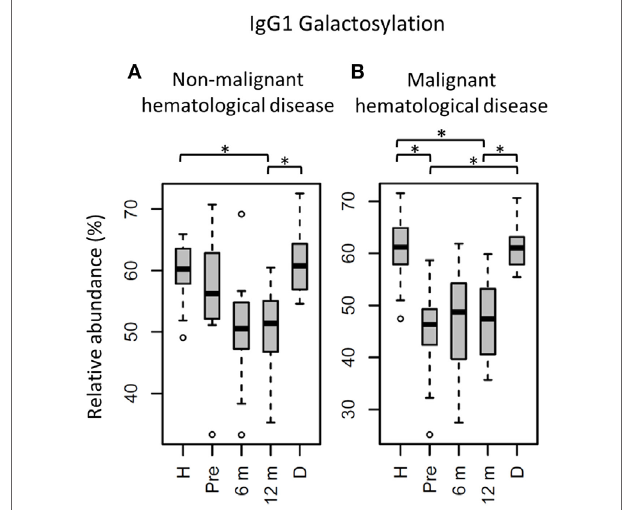
FigUre 4 | IgG1 fragment crystallizable (Fc) galactosylation in all patients stratified on diagnose, compared to their donors and age-matched healthy controls. IgG1 Fc galactosylation in children (a) with non-malignant hematological diseases and (b) with malignant hematological diseases. H: age-matched healthy controls, Pre: patients prior to hematopoietic stem cell transplantation (HSCT), 6 m: patients 6 months after HSCT, 12 m: patients 12 months after HSCT, D: donors prior to HSCT. Patients and donors were compared by Wilcoxon signed-rank tests, healthy controls and patients with Mann–Whitney U tests. p -Values < 0.015 were considered statistically significant after 5% FDR correction (as indicated by the asterisks above the plots). For non-malignant hematological diseases, n (H, Pre, 6 m, 12 m, D) = 18, 16, 18, 18, 14, for malignant hematological diseases, n (H, Pre, 6 m, 12 m, D) = 16, 16, 16, 16, 15,